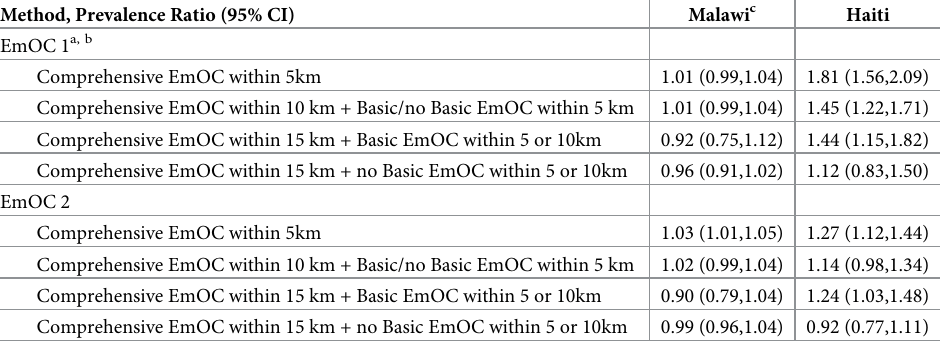
Table 3. Adjusted association between proximity to obstetric care on facility utilization for delivery care among women in Malawi and Haiti using two EmOC assessment methods: Demographic Health Surveys and Service Pro- vision Assessments